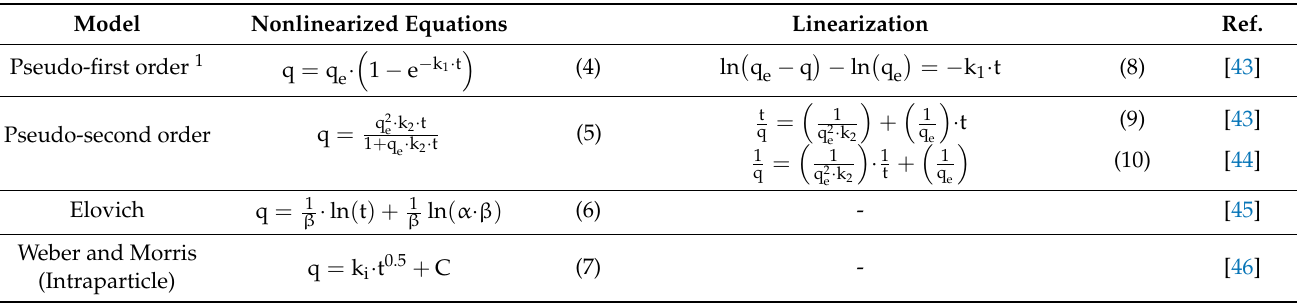
Table 1. The nonlinear and linearized equations of the analyzed kinetic models.